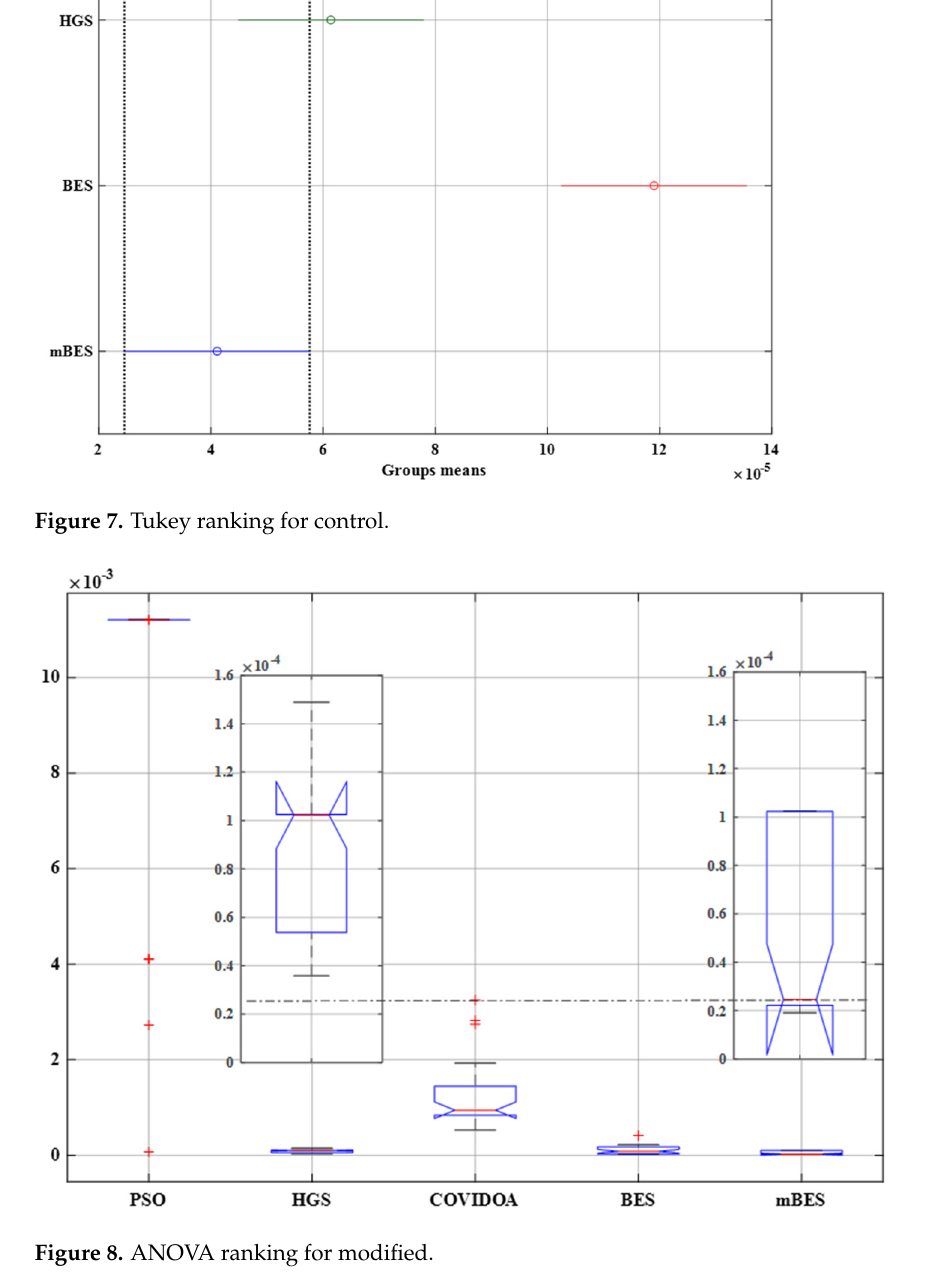
Figure 8. ANOVA ranking for modified.